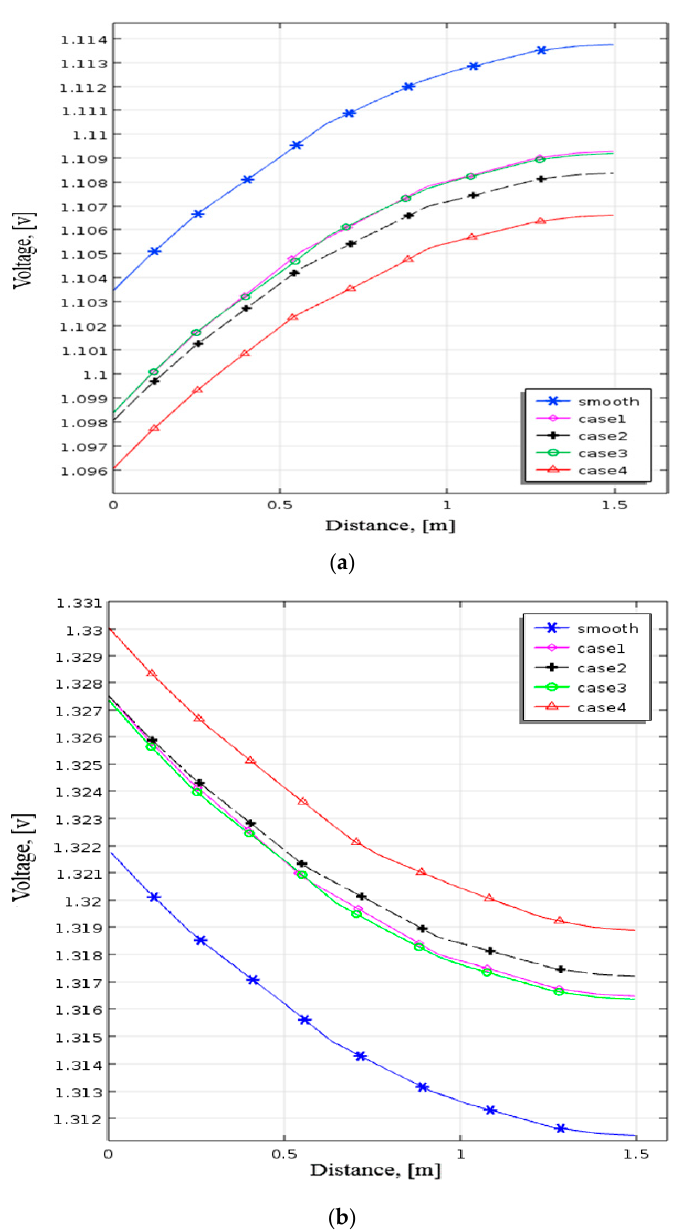
Figure 9. Profile of terminal voltage at positive electrode for smooth channel and varied baffle row cases during ( a ) discharging and ( b ) charging from numerical analysis.